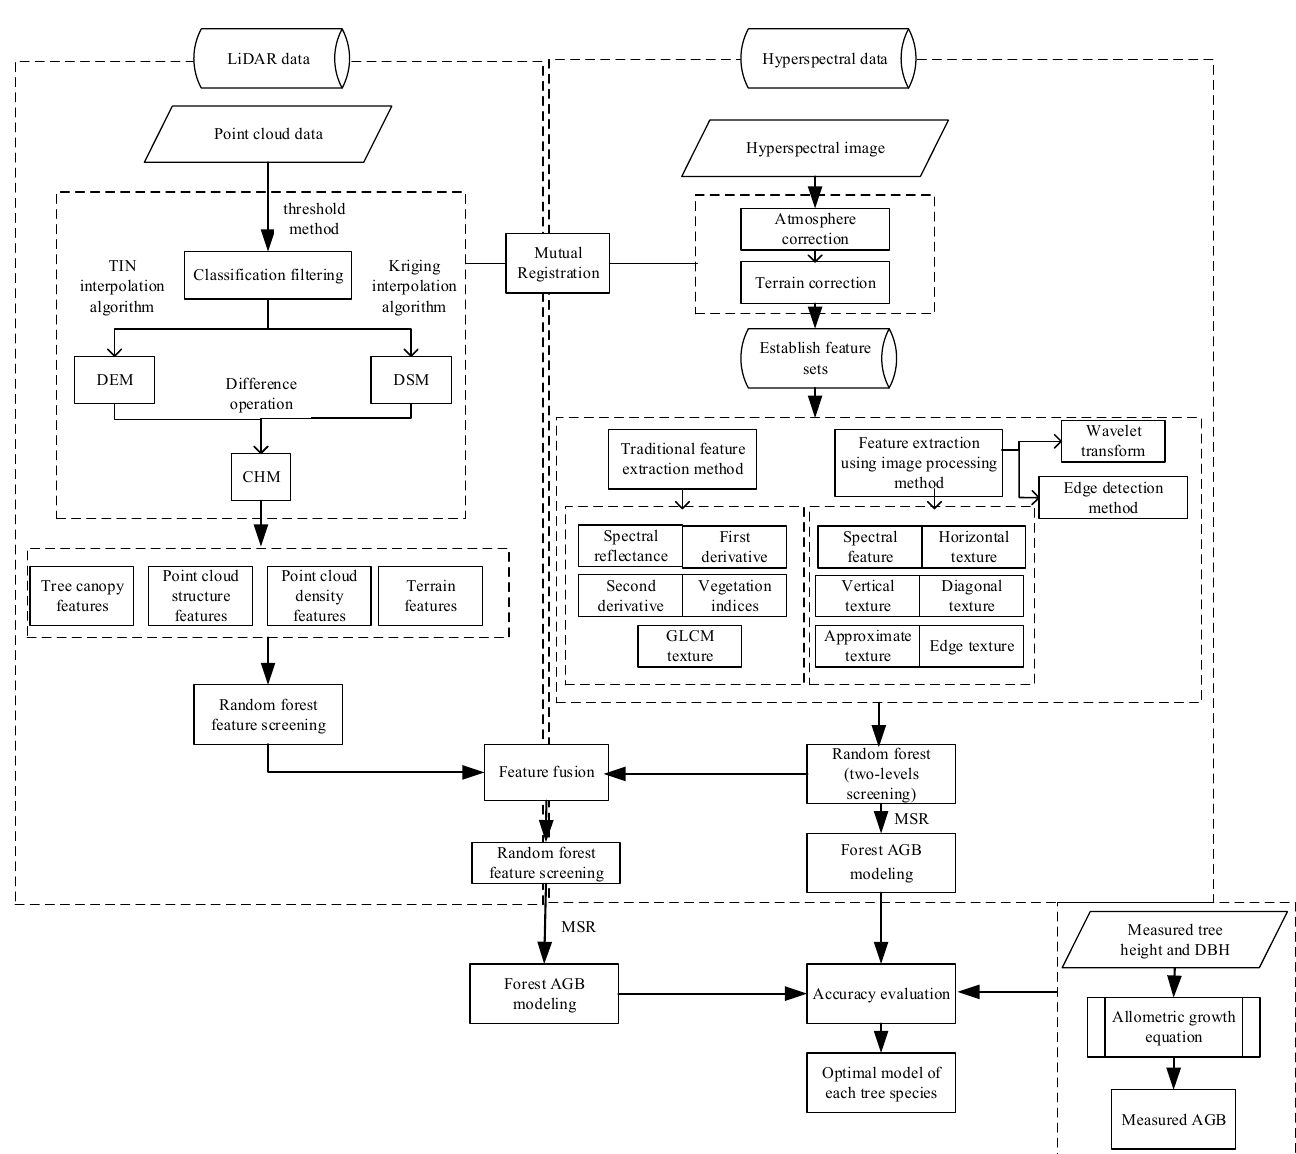
Figure 3. Three-level screening and modeling process.